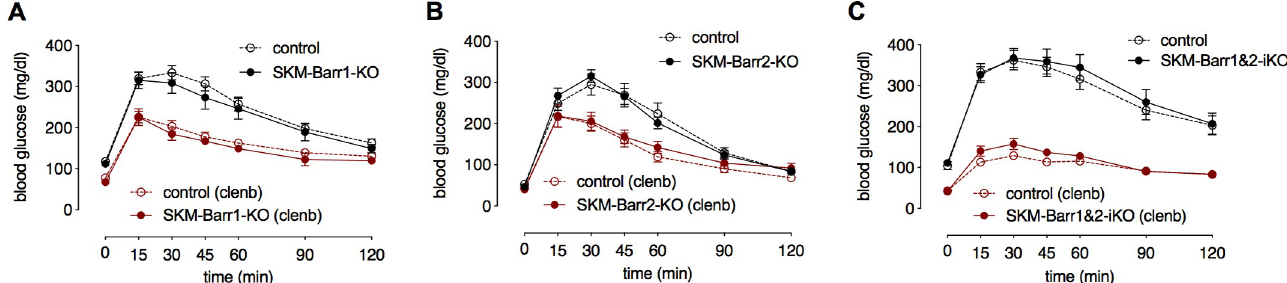
Fig 5. SKM β -arrestins are not required for clenbuterol-mediated improvements in glucose tolerance. Glucose tolerance tests were carried out with male adult mutant mice and their control littermates. Mice were treated with the selective β 2 -AR agonist clenbuterol (clenb) by adding clenb (30 mg/l) to the drinking water for 5 days (red lines). Mice consuming regular drinking water are represented by the black lines. (A) SKM-Barr1-KO and control mice. (B) SKM-Barr2-KO mice and control mice. (C) SKM-Barr1&2 double KO and control mice. Data are shown as mean ± SEM (8–12 mice per group). iKO, inducible KO.